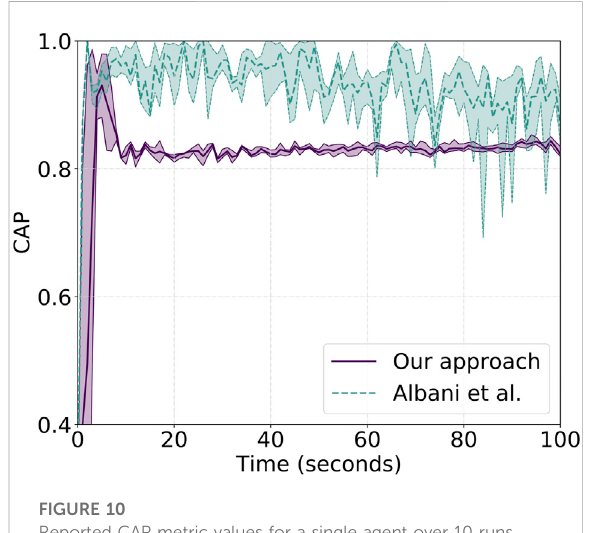
FIGURE 10 Reported CAP metric values for a single agent over 10 runs both for “ our approach ”— solid purple line — and the work of Albani etal. (2022) — dashed light-greenline.Highery-values show better CAP performance.